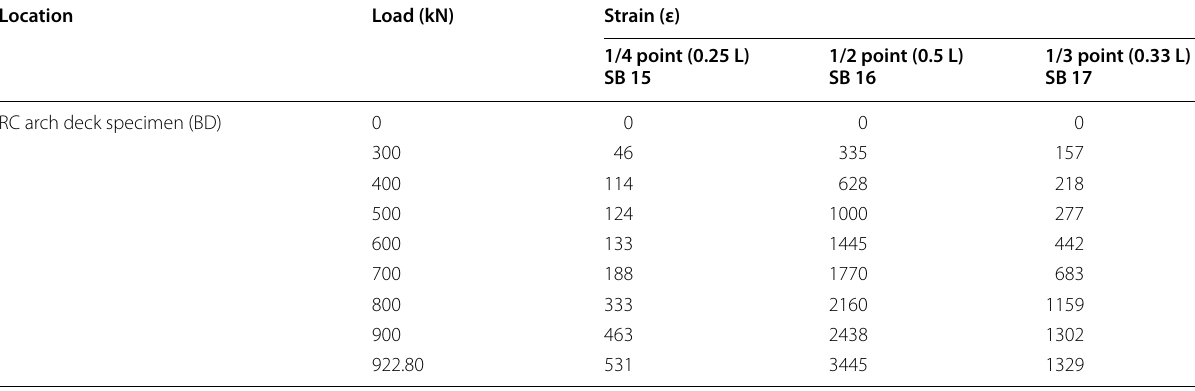
Table 9 Test results of load–steel strain data